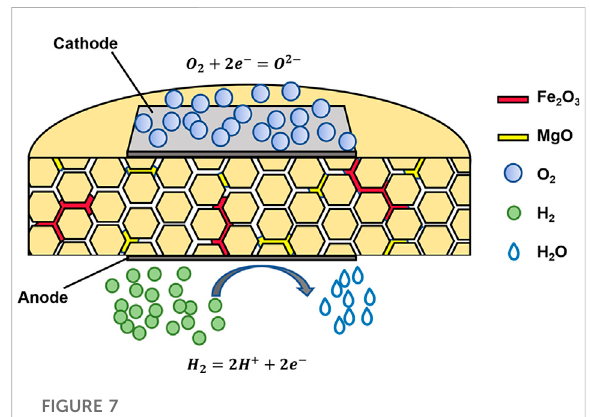
FIGURE 7 Schematicdiagramofthefull-cell modelsupportedbyGDC- MF